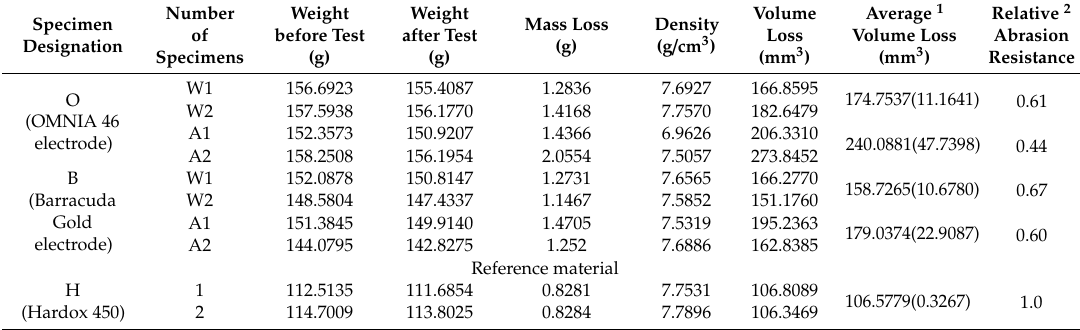
Table 2. Results of abrasive wear resistance test.